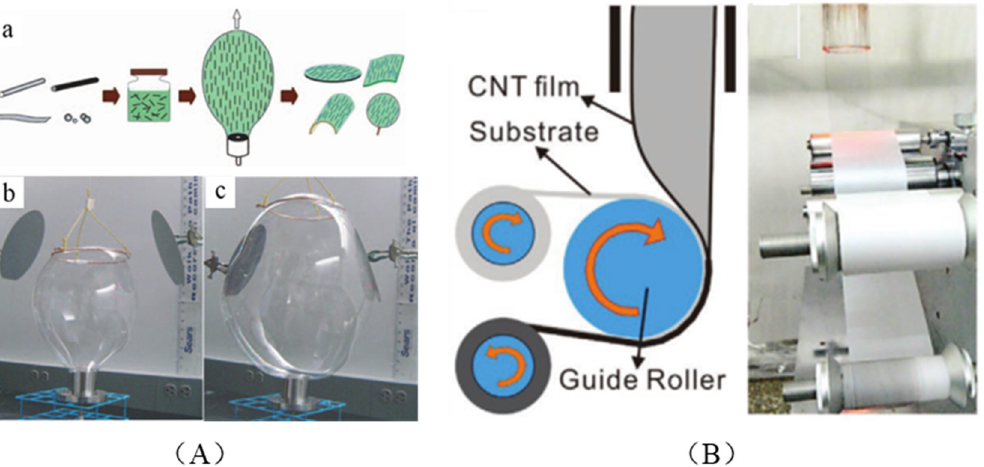
Figure 12. ( A ) ( a ) Schematic of blown bubble films method; ( b , c ) Pictures of the initial and final stage of blown bubble method. Reproduced with permission [86]. Copyright 2008, Royal Society of Chemistry. ( B ) Schematic of the apparatus and Photograph of collecting process. Reproduced with permission [44]. Copyright 2020, John Wiley and Sons.